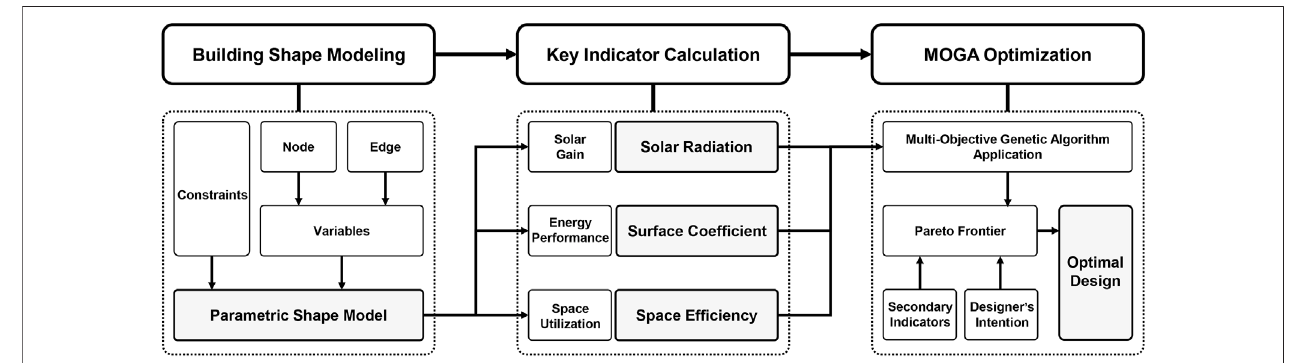
FIGURE 3 | The “ Modeling-Calculation-Optimization ”